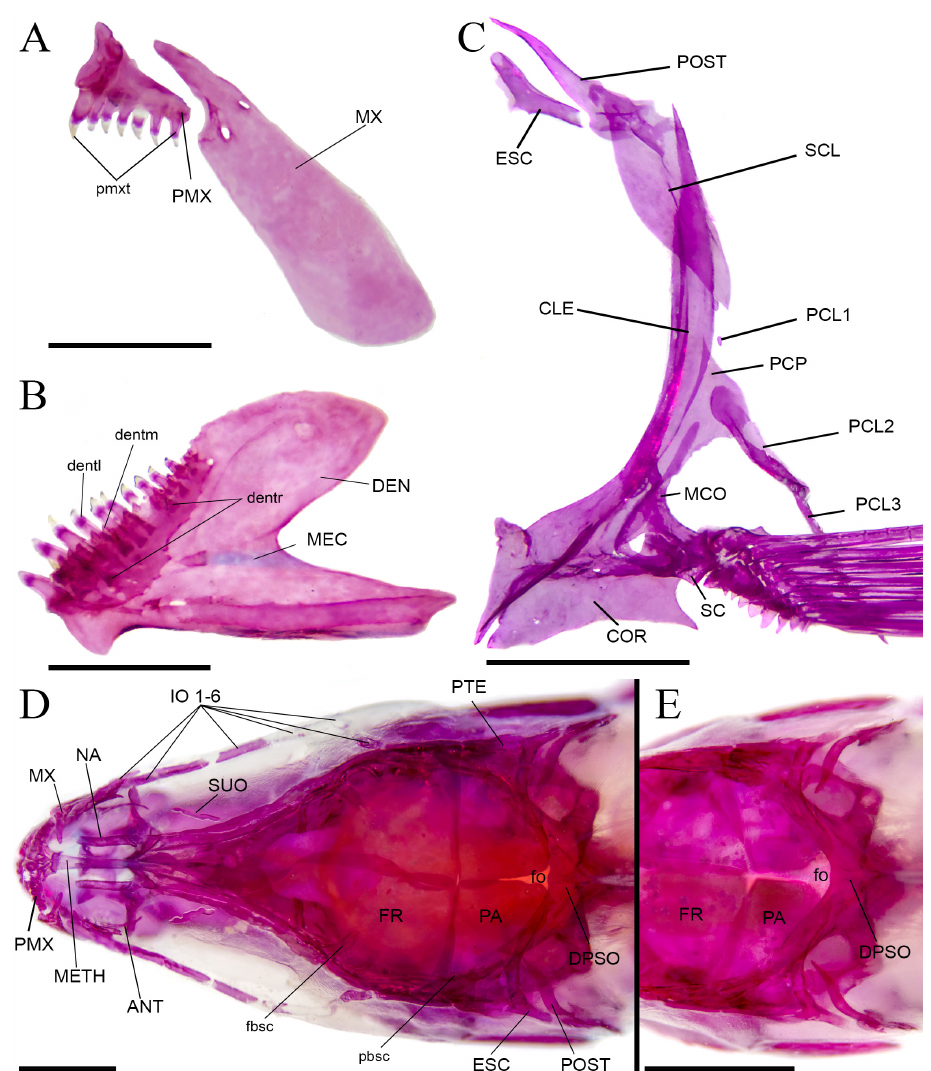
FIGURE 3 | Osteological characteristics in Characidium onca , paratypes: A . Right upper jaw in medial view (MZUSP 125803); B . Right dentary in medial view (MZUSP 125803); C . Left pectoral gridle in lateral view (MZUSP 125801); D . Skull in dorsal view (MZUSP 125803); E . Posterior portion of skull in dorsal view (MZUSP 125801). Abbreviations: ANT, antorbital; CLE, cleithrum; COR, coracoid; DEN, dentary; dentl, lateral row of dentary teeth; dentm; middle row of dentary teeth; dentr, replacement lateral row of dentary teeth; DPSO, dorsal process of the supraoccipital; ESC, extrascapular; FR, frontal; fbsc, frontal branch of the supraorbital canal; fo, fontanel; IO 1–6, infraorbitals 1 to 6; MCO, mesocoracoid; MEC, Meckel’s cartilage; METH, mesethmoid; MX, maxilla; NA, nasal; PAR, parietal; pbsc, parietal branch of the supraorbital canal; PCP, posterior cleithral process; PCL 1–3, postcleithrum 1 to 3; PMX, premaxilla; pmxt, premaxilarry teeth; pmxtr, replacement premaxillary teeth; POST, posttemporal; PTE, pterotic; SC, scapula; SCL, supracleithum; SUO, supraorbital. Scale bar = 1